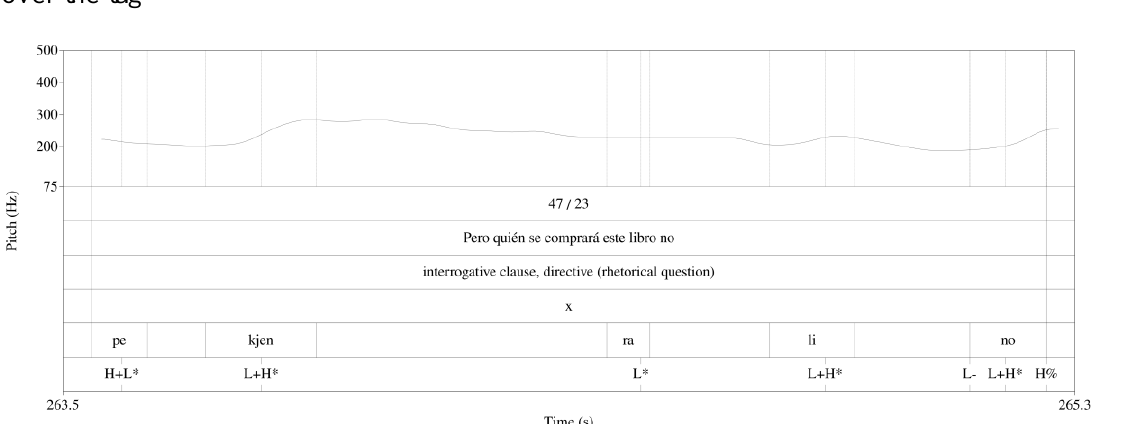
Figure 3. ¿Pero quién se comprará este libro, no? realized with a light rising contour over the